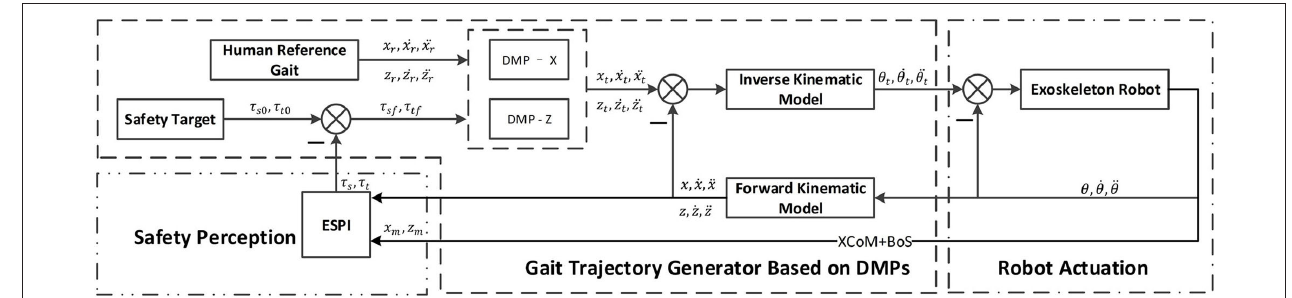
FIGURE 1 | The architecture of the balance control strategy. When the XCoM, Base of Support (BoS), and the gait information of the human-exoskeleton system are collected, the scalar Φ and vector υ values of ESPI can be calculated, and the spatial and temporal scaling parameters ( τ sf , τ tf ) for the gait generator will be calculated. Once the scaling parameters are entered, the gait trajectory generator could plan a new gait based on dynamic movement primitives (DMPs) taking the standard gait as a reference. Additionally, joints trajectories generated by the inverse kinematic model could be executed by the exoskeleton robot to keep the system safe.